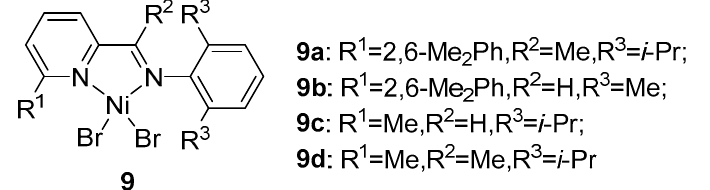
Figure 7. Pyridylimino Ni(II) catalysts 9a – d .